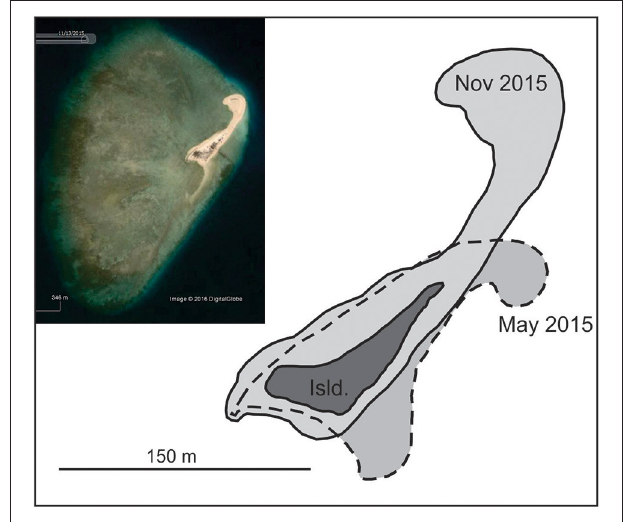
(Island 5 in Figure 2 and Table 1), a small vegetated sand cay on the outer shelf (Satellite image from Google TM , © 2017